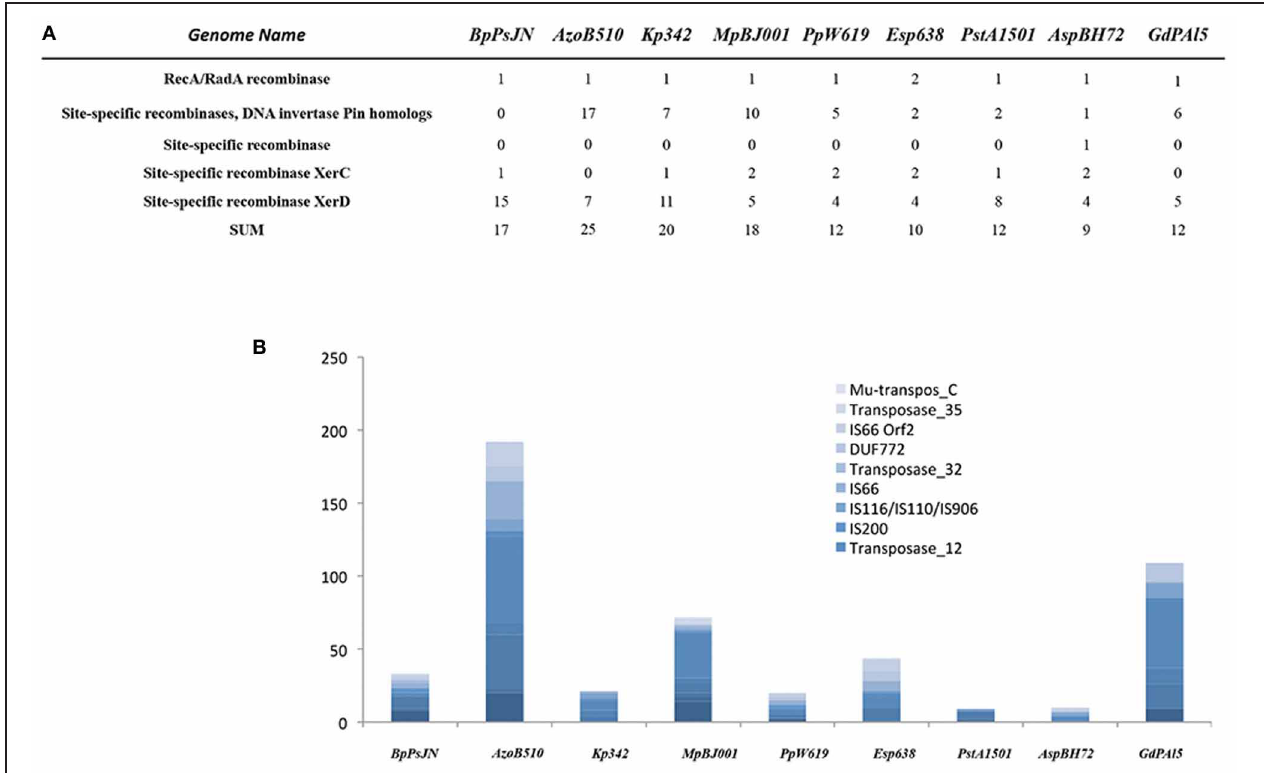
FIGURE 3 | Transposase genes (A) and mobile genetic elements (B) in the selected endophyte